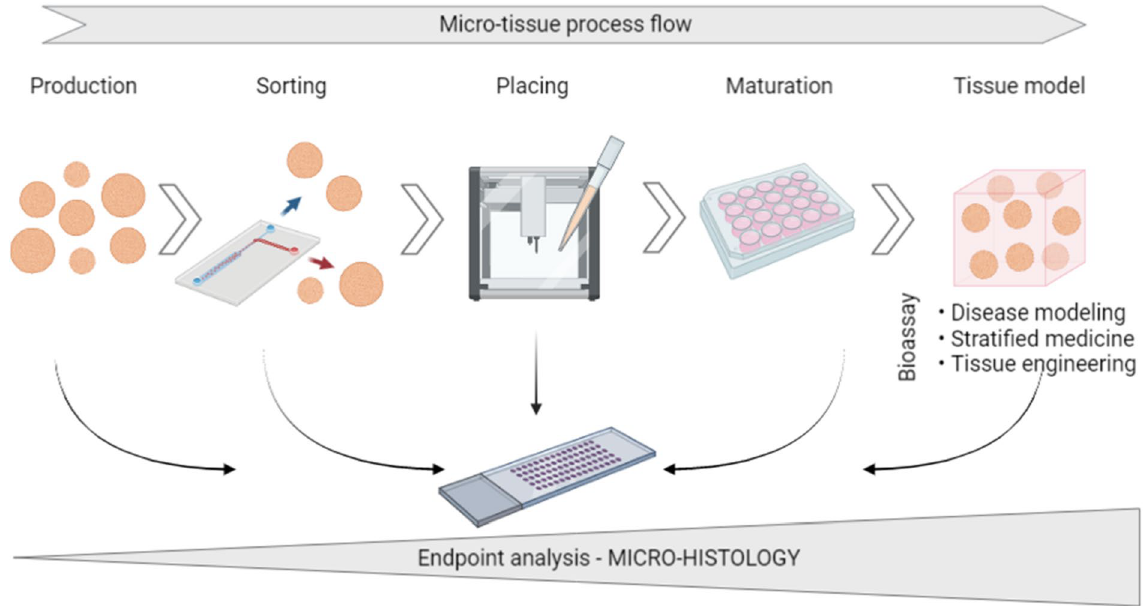
Figure 1. Micro-tissue processing chain showing the increasing need for micro-histology. In addition to endpoint analysis and by giving access to the micro-anatomy and biology of micro-tissues, micro-histology helps to determine the effect of processing steps on the samples (e.g., stress or damages affecting the morphology and biological functions, when combined with immunohistochemistry). Thus, it is the method of choice for quality control for the implementation of new methods serving the complete micro-tissue process flow, from production to tissue model development. Created with